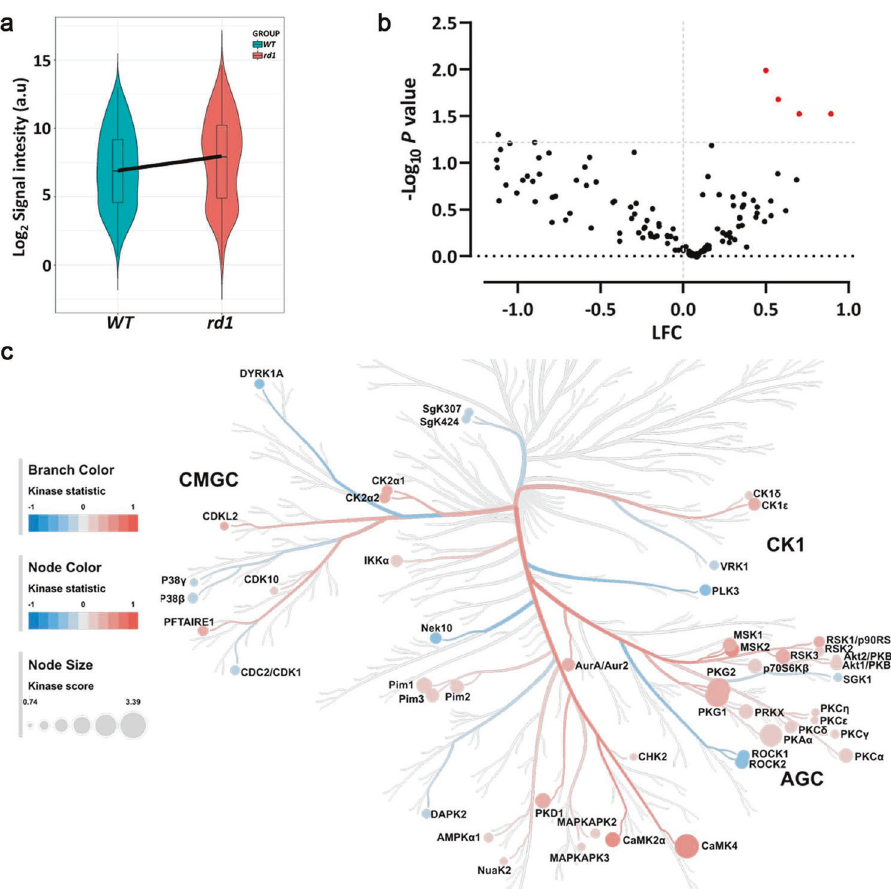
Fig. 2 Serine/Threonine Kinase (STK) activity in untreated retinal explants. Organotypic retinal explants derived from wild-type (WT) and rd1 mice (WT, n = 5; rd1 , n = 8) were maintained in culture medium from P5 till P11. The kinase activity of their lysates was measured on PamChip ® Serine/Threonine kinase (STK) arrays. a Violin plot showing the global phosphorylation of the peptides on PamChip ® STK array as Log 2 signal intensity and their intensity value distribution, when comparing WT to rd1 explants. The thick line connects the average values of each group. b Volcano plot representing Log Fold Change (LFC) and − Log 10 p- value for peptide phosphorylation. Red dots indicate signi fi cantly changed phosphopeptides ( p- value < 0.05), black dots represent peptides with no signi fi cant alteration in phosphorylation. c The high-ranking kinases were visualized in a kinome phylogenetic tree, where branch and node color are encoded according to the kinase statistic, with values > 0 (in red) representing higher kinase activity in rd1 retinal explants. The node size is encoded by the kinase score, that ranks kinases based on their signi fi cance and speci fi city in terms of sets of peptides used for the corresponding